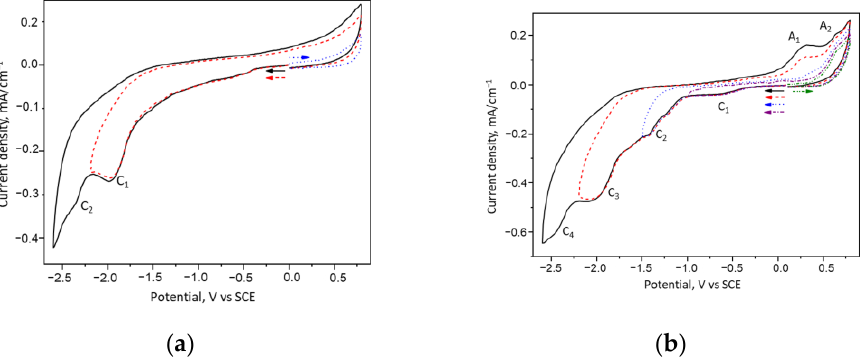
Figure 2. CV curves of ( a ) dmaeRA and ( b ) salRA in DMF/0.1 M Bu 4 NCl, C = 1 mM, ν = 0.1 V/s.